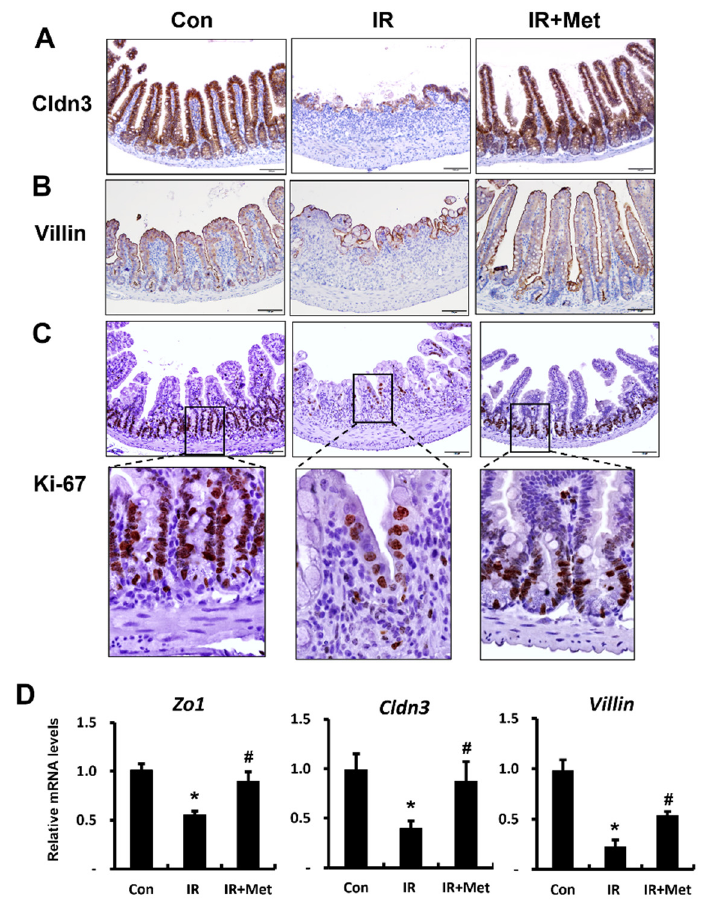
Figure 3. Metformin enhanced tight-junction expression with epithelial proliferation in the irradi- ated intestine. Immunohistochemistry of ( A ) Claudin3 (Cldn3), ( B ) Villin, and ( C ) Ki-67 in the intestine of control (Con), irradiated (IR), and metformin-treated IR (IR + Met) mice at 6 days after radiation exposure. Bar = 50 μ m. ( D ) The mRNA levels of Zonula occludens1 ( Zo1), Cldn3, and Villin in the Con, IR, and IR + Met groups, as determined by real-time RT-PCR. Levels of mRNA expression are shown as the fold induction relative to the expression in Con group. Data are presented as the mean ± standard error of the mean; n = 6 mice per group. * p < 0.05 compared to the Con group; # p < 0.05 compared to the IR group.